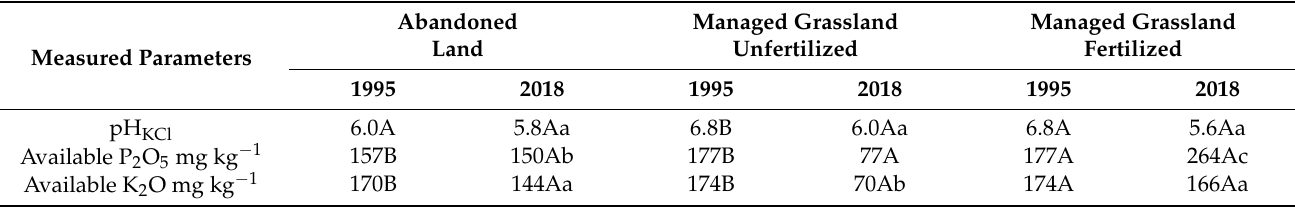
Table 1. Soil pH KCl and plant available P 2 O 5 and K 2 O content (mg kg − 1 ) in the soil at the beginning of the experiment (1995) and in